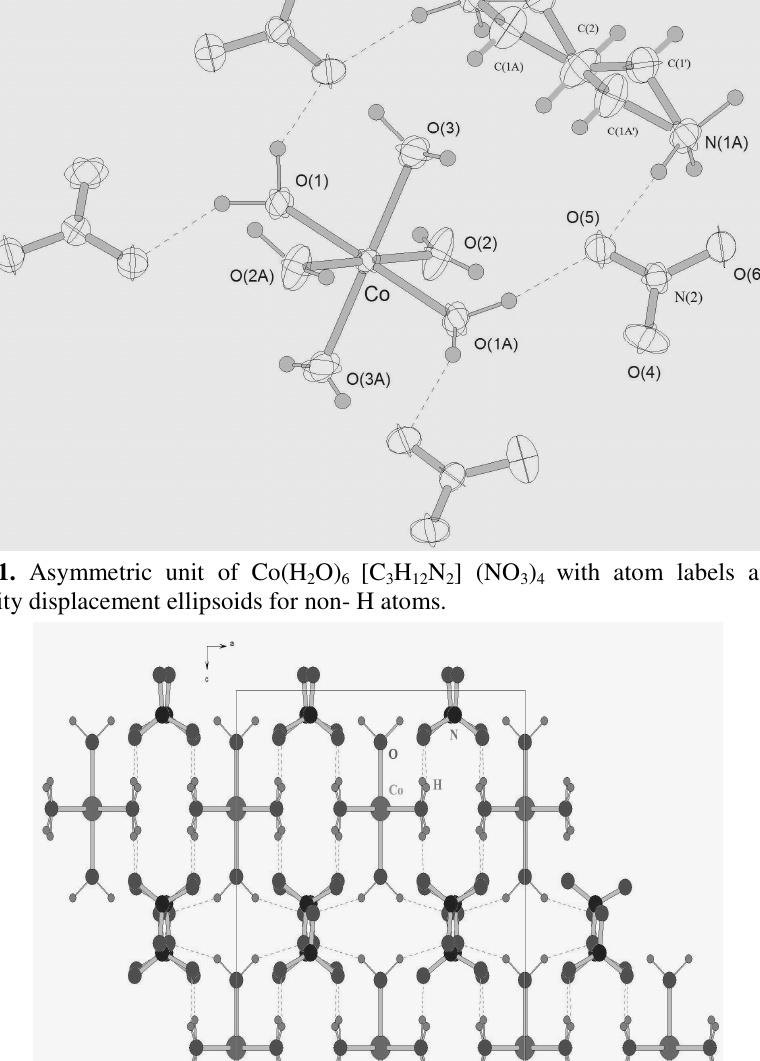
Figure 2. Projection of the structure of Co(H bonds are denoted by dotted